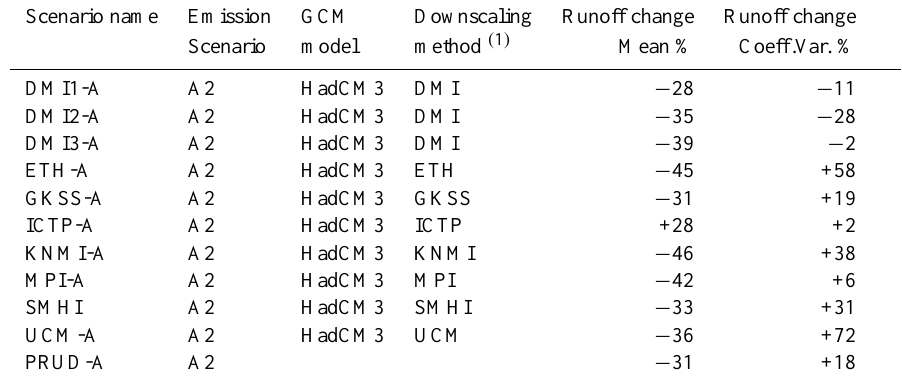
Table 3. Climate change runoff projections in the Ebro basin taken from PRUDENCE project. Scenario name Emission GCM